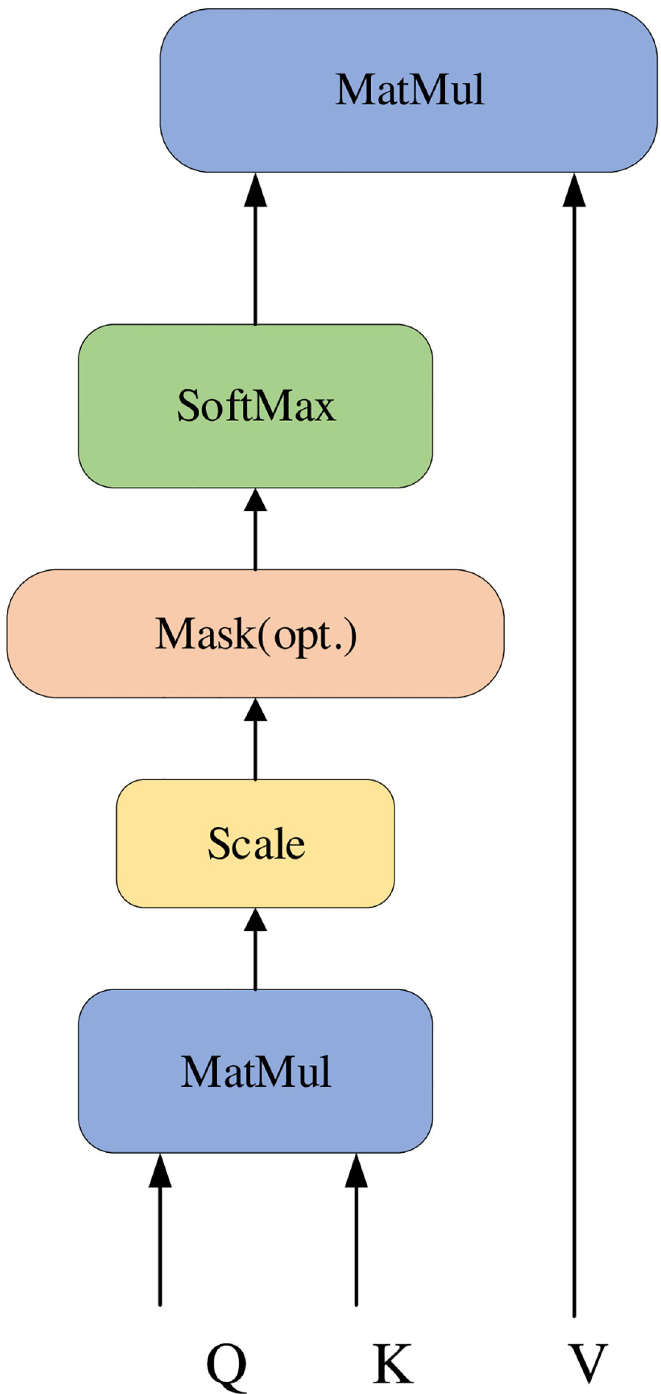
Fig 4. Scaled dot product attention structure. (Q) means the query matrix. (K) means the key matrix. (V) means the value matrix. (Mask) represents matrix operations for processing non-fixed-length sequences. ( for